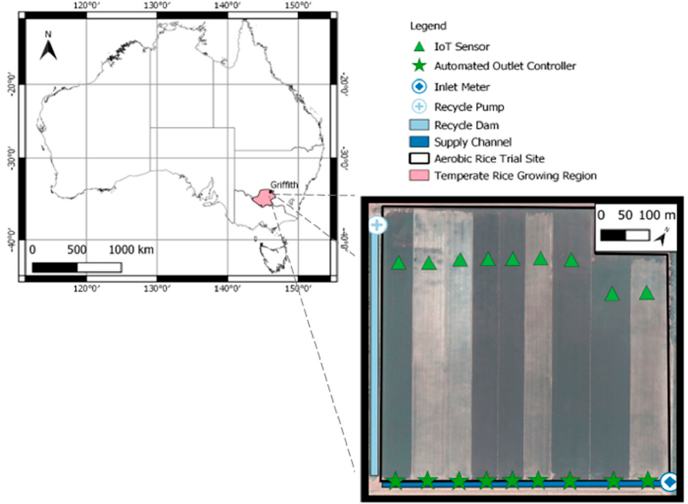
Figure 2. Location of the commercial field site where the 2-year study was conducted in relation to the Australian temperate rice region.